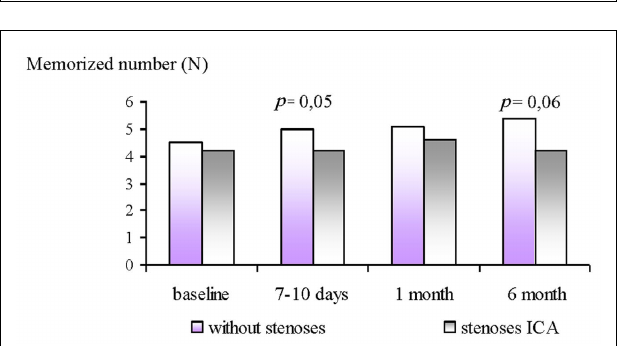
FIGURE 3 | Dynamics of memorized numbers in ICA stenoses patients and without ones at 6month follow-up after